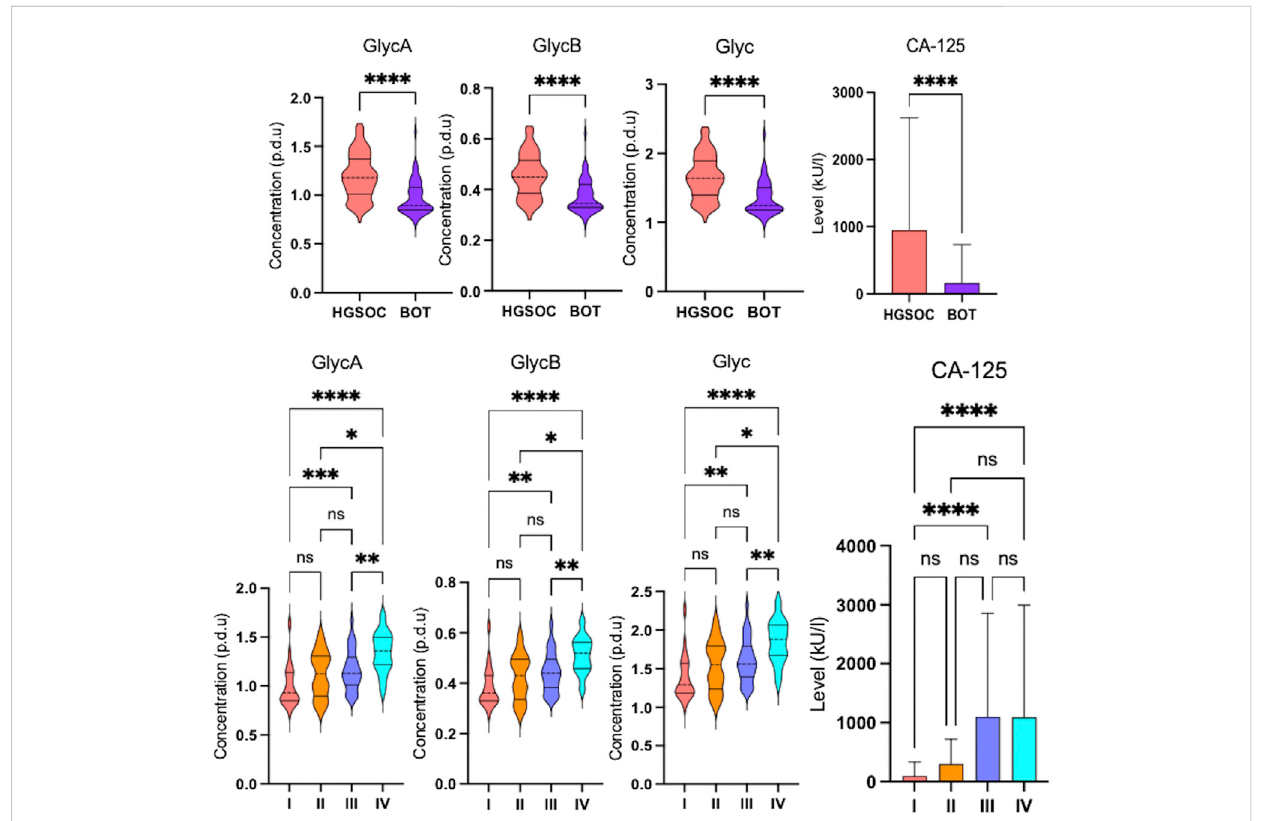
FIGURE 4 Altered glycoprotein in fl ammation and cancer antigen-125 markers in ovarian cancer serum samples. Violin and box plots showing signi fi cant increase in glycoprotein in fl ammation and cancer antigen-125 markers overtheclinicalstages(q-value =* < 0.05, ** < 0.01, *** < 0.001, and **** < 0.0001) that they are higher in high-grade serous ovarian cancer than in borderline ovarian tumor (FDR < 0.001, * < 0.05, ** < 0.01, *** < 0.001, and **** <